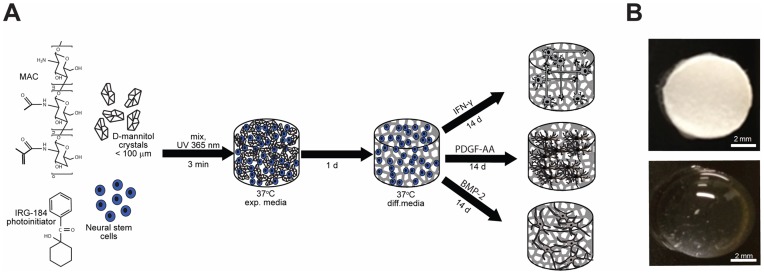
(A) Methodology for creating 3D porous MAC scaffolds and procedure for NSPC culture and differentiation in 3D environments. (B) Images of a 20% D-mannitol scaffold captured immediately after crosslinking and after PBS dissolution for 1 hr at 37°C.